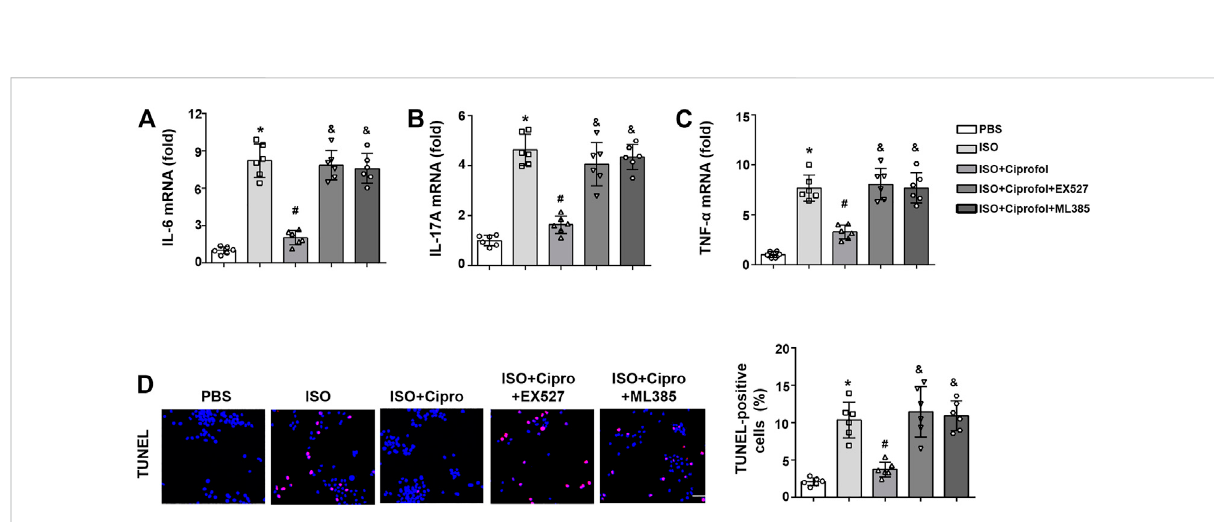
FIGURE 9 Sirt1 and Nrf2 inhibition abolished the anti-in fl ammation and anti-apoptosis effects of ciprofol in vitro . The mRNA levels of IL-6 (A) , IL-17A (B) and TNF- α (C) weremeasured( n = 6). (D) Representative images of TUNEL staining ineachgroup ( n =5). p p < 0.05 compared to thePBS group. # p < 0.05 compared to the ISO group. & p < 0.05 compared to the ISO + ciprofol